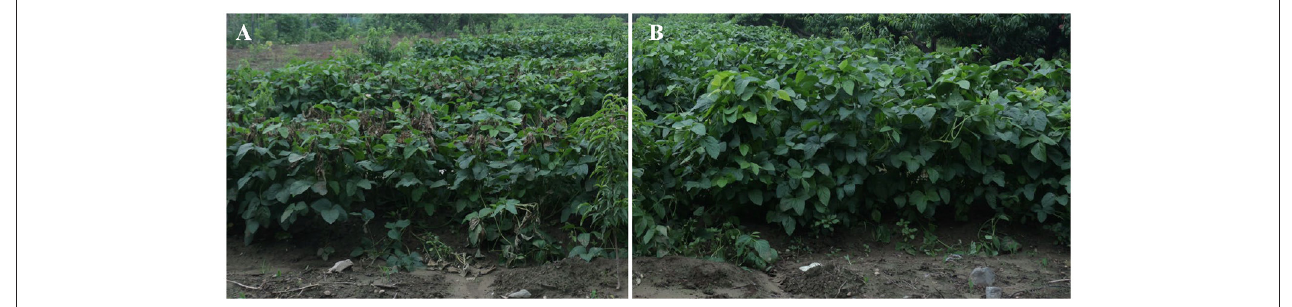
FIGURE 3 | Control efficacy of wuyiencin against Sclerotinia stem rot in soybean. The field study evaluated the effectiveness of treating infected soybean plants with 200 µ g/mL wuyiencin. The left-hand side was not treated with any chemical fungicide as a negative control (A) and the right-hand side of the protective rows was treated with wuyiencin (B)